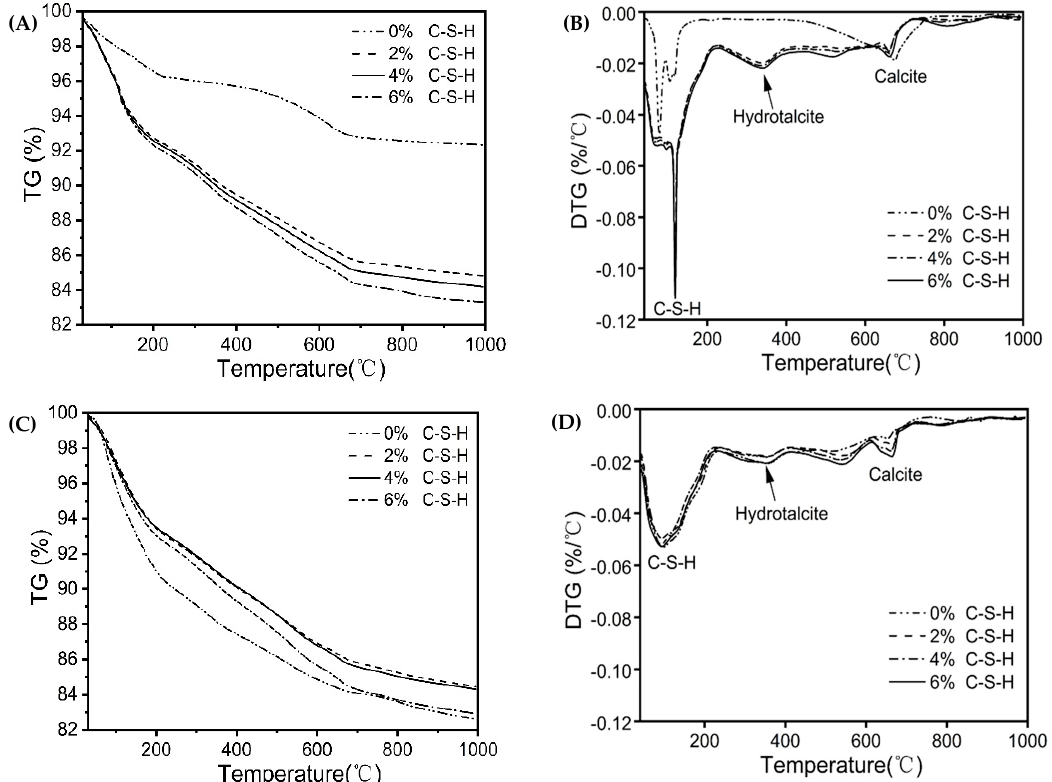
Figure 7. Decomposition of samples with C-S-H seeds as a function of temperature: ( A ) mass loss after 1 d of hydration, ( B ) derivative thermogravimetry after 1 d of hydration, ( C ) mass loss after 28 d of hydration, and ( D ) derivative thermogravimetry after 28 d of hydration.